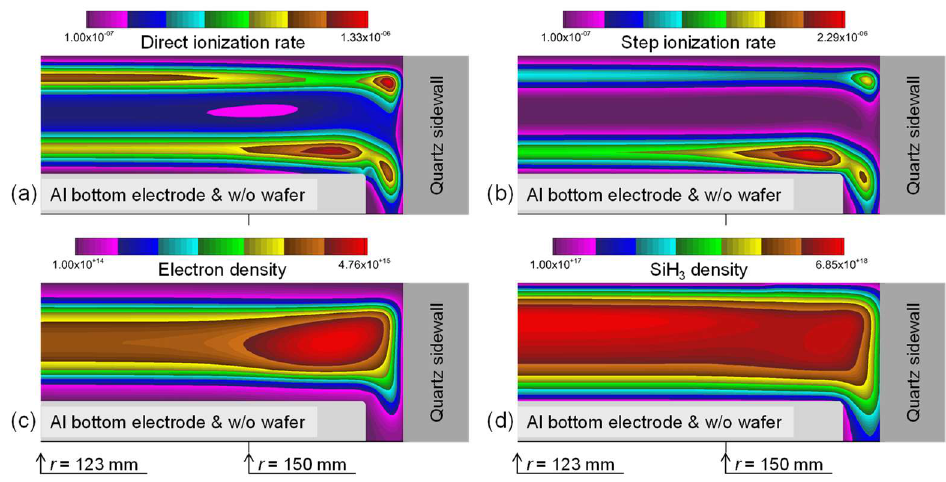
Figure 2. Contour plots for the spatial profiles of the time-averaged ( a ) SiH 2+ production rate for Case 1 and ( b ) Si + production rate for Case 1 for r ≥ 123 mm. Contour plots for the spatial profiles of the time-averaged ( c ) electron density for Case 1 and ( d ) SiH 3 density for Case 1 for r ≥ 123 mm. The profiles are radially uniform for r < 123 mm.